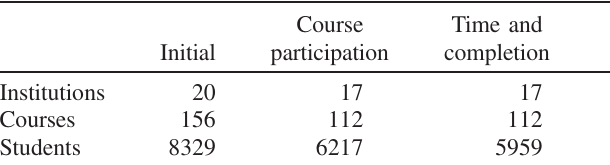
TABLE III. Size of the dataset after each step of filtering.